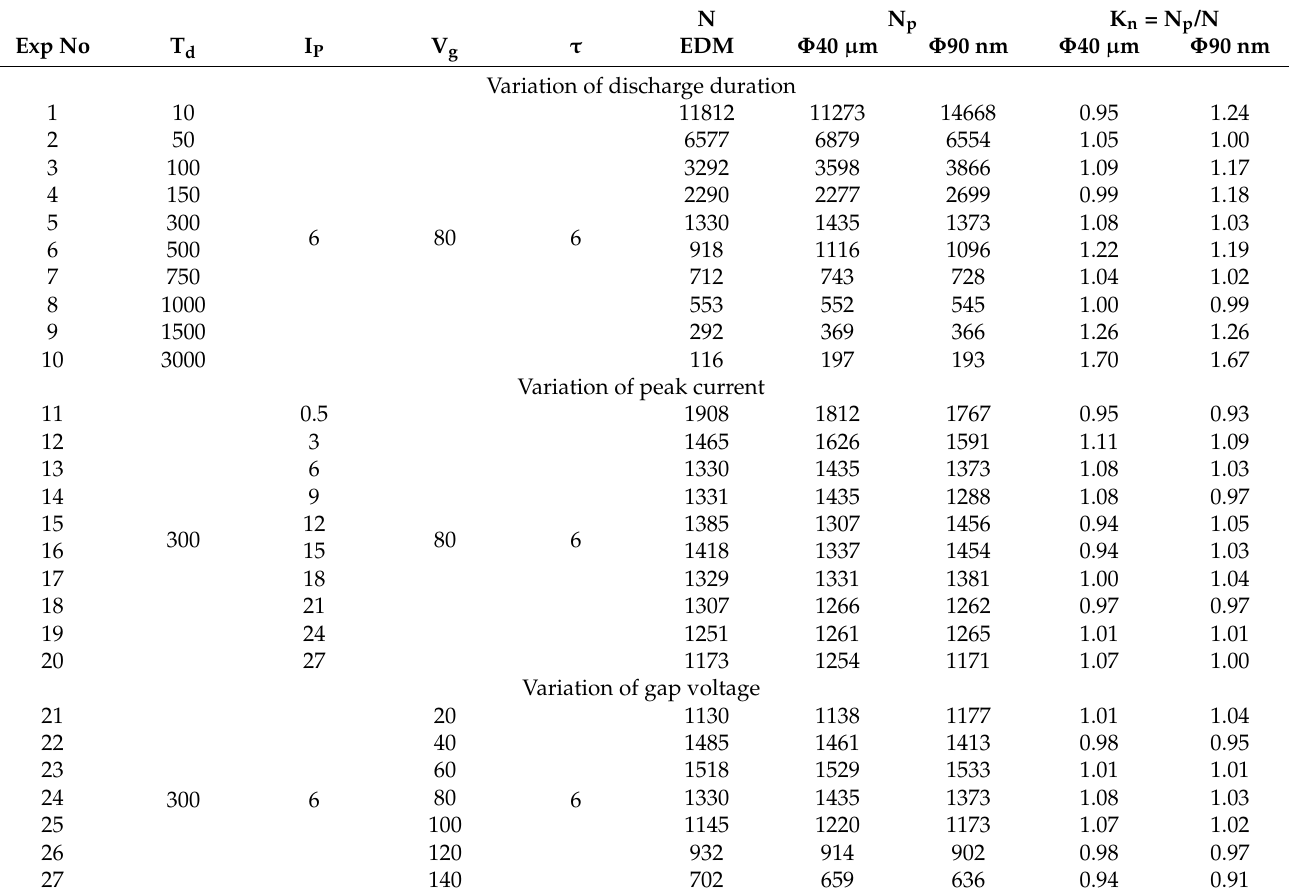
Table 3. Effect of input process parameters on N, N p , and K n .